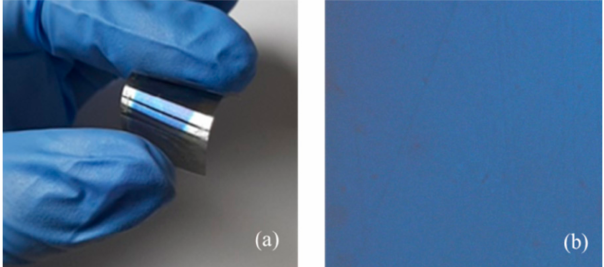
Figure 6. Picture of the bent sensor ( a ) and optical image of the surface of the PET/polymer sensor after 1000 bending deformations at magnification of 100 × ( b